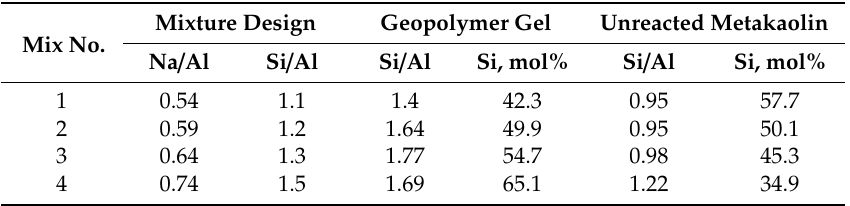
Table 2. Amount and composition of geopolymer gel and unreacted metakaolin in the non-Ca mixtures as determined using NMR.